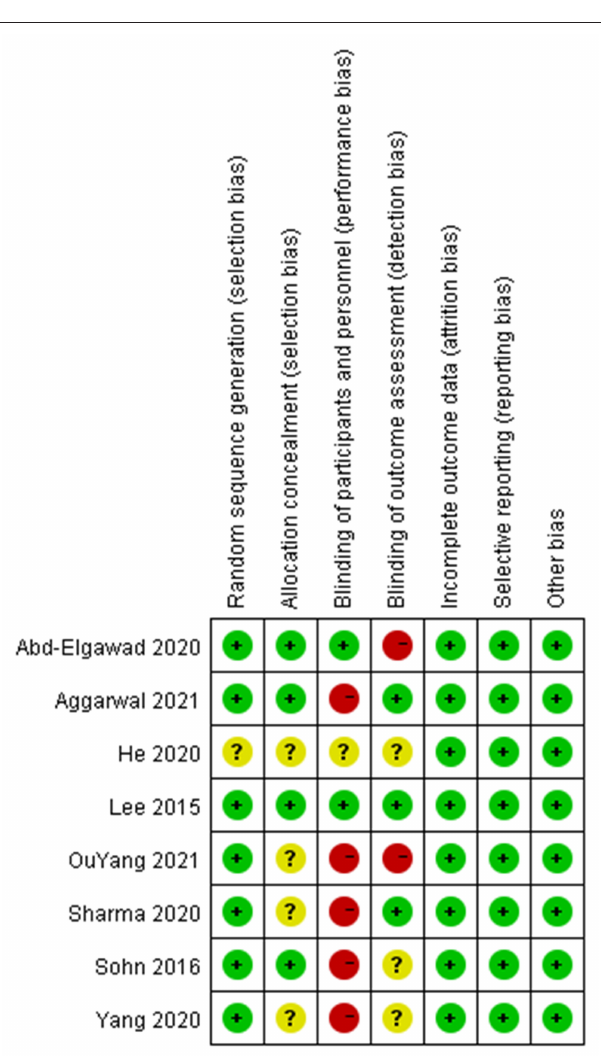
FIGURE 2 | Authors’ judgments about each risk of bias item for each included